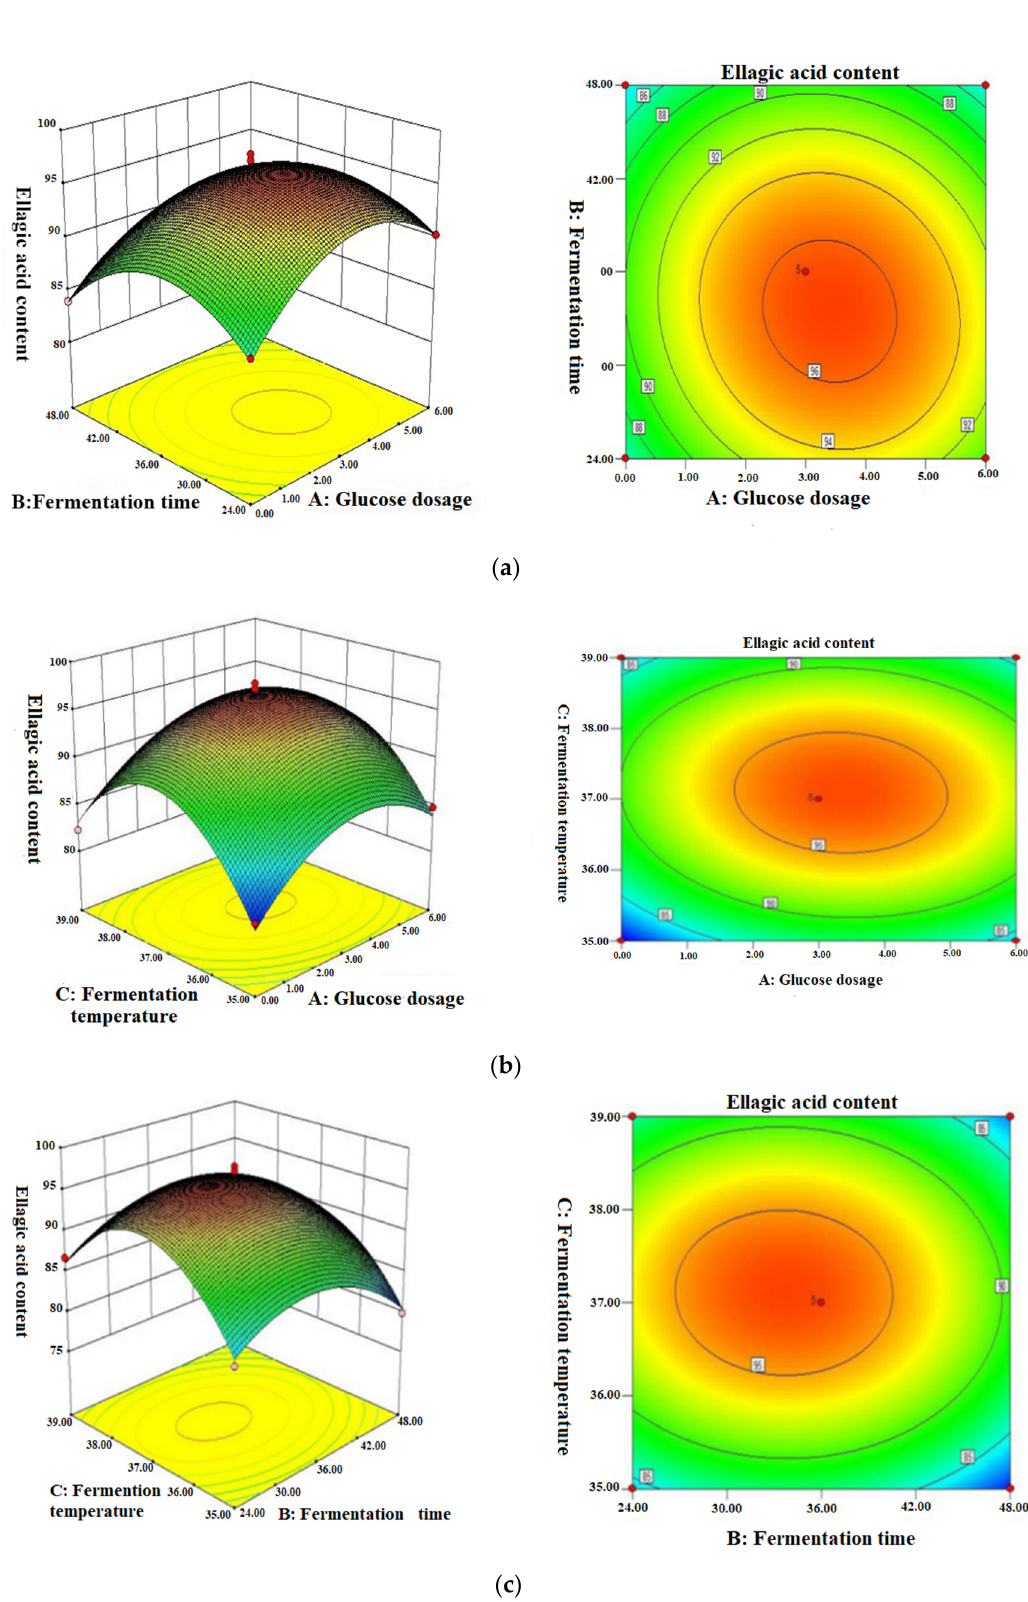
Figure 2. Response surface plots: ( a ) glucose dosage and fermentation time on the ellagic acid content, ( b ) glucose dosage and fermentation temperature on the ellagic acid content and ( c ) fermentation time and fermentation temperature on the ellagic acid content.